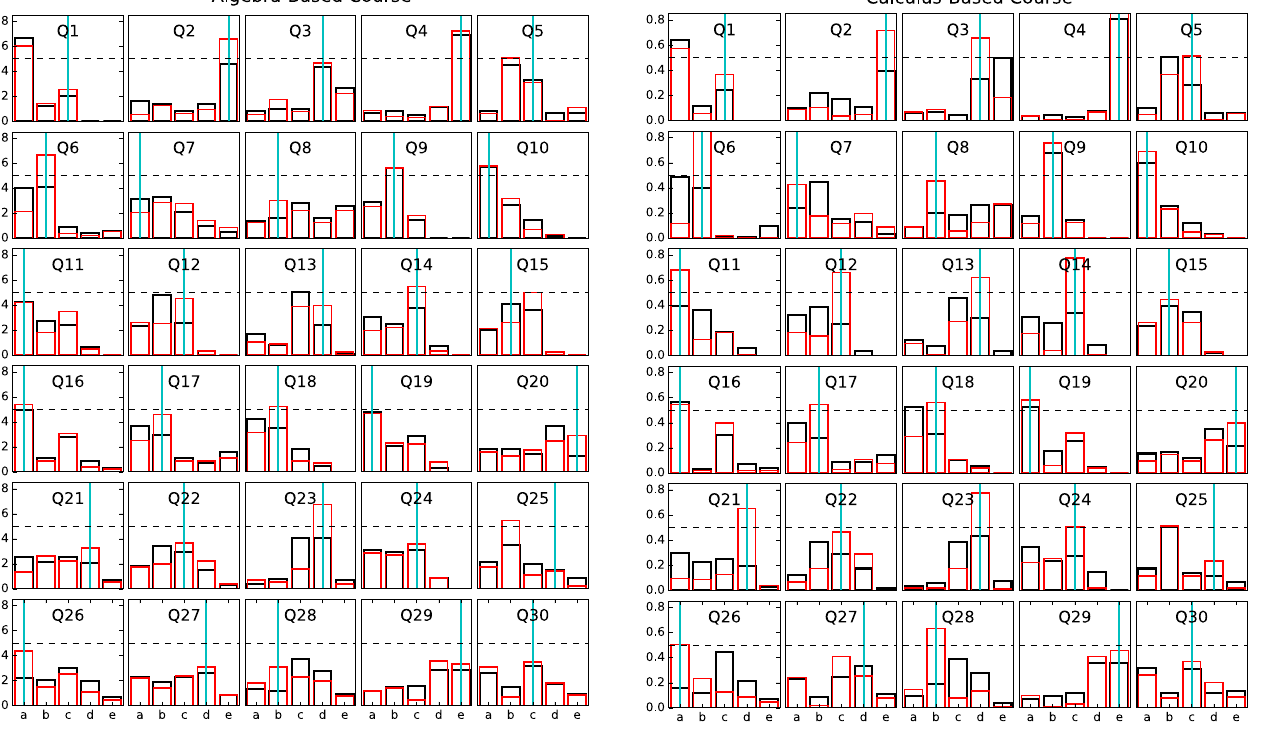
FIG. 5. EMCA question choices and answers for the calculus- based classes. Black represents the pretest selection and red represents the post-test selection. The cyan vertical line represents the correct answer. The y axis shows the fraction of the overall population that selected each choice. The dashed horizontal line marks 50% of the total number of students with matched pre- and post-test